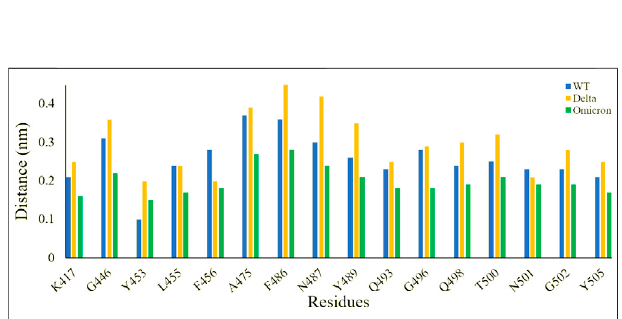
FIGURE 4 | Root mean square fl uctuation of receptor binding motifs of SARS-CoV-2 WT, Delta, and Omicron